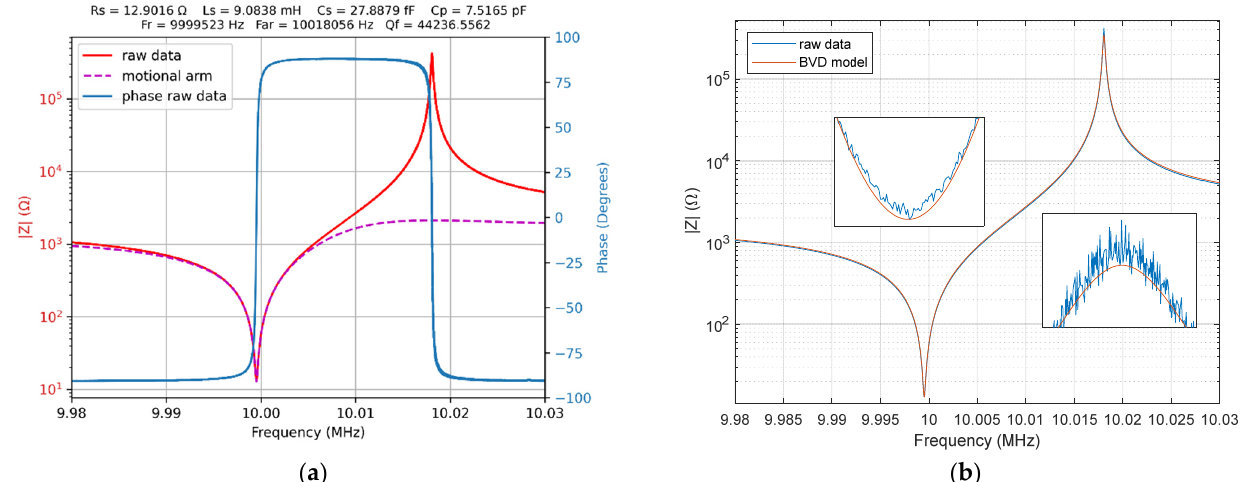
Figure 8. ( a ) Impedance and phase of the QCM sensor in air and real ‐ time parameter computation, Method 1: Resonance Frequencies. ( b ) BVD model fit using QCM sensor parameters.